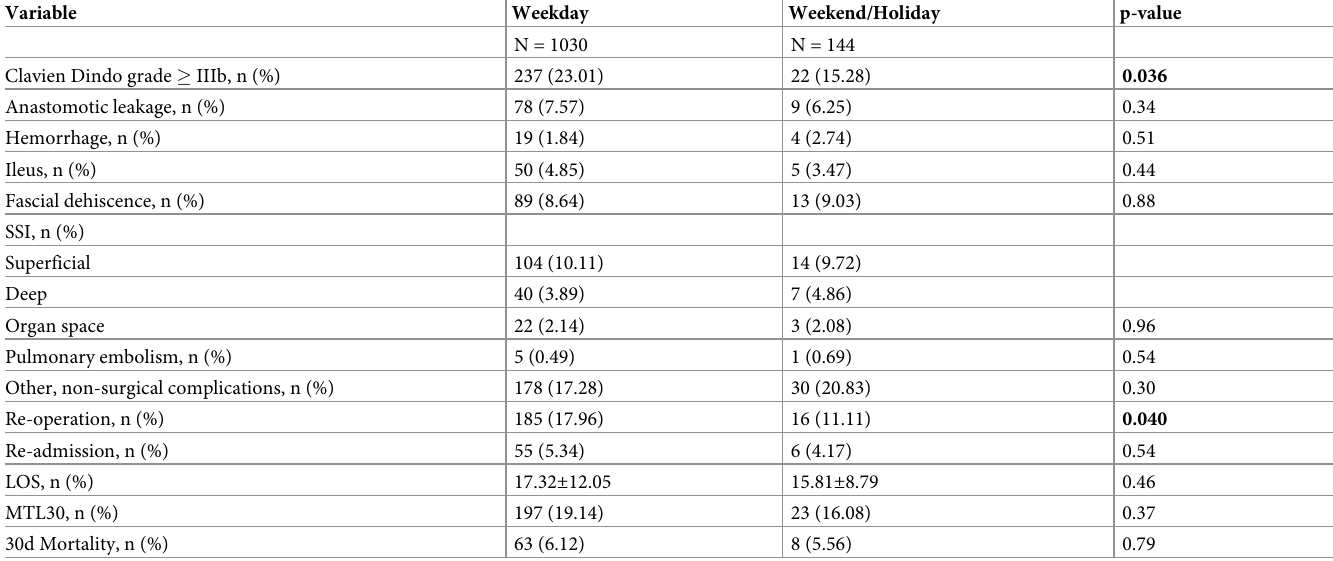
Table 2. Postoperative outcome by weekday of